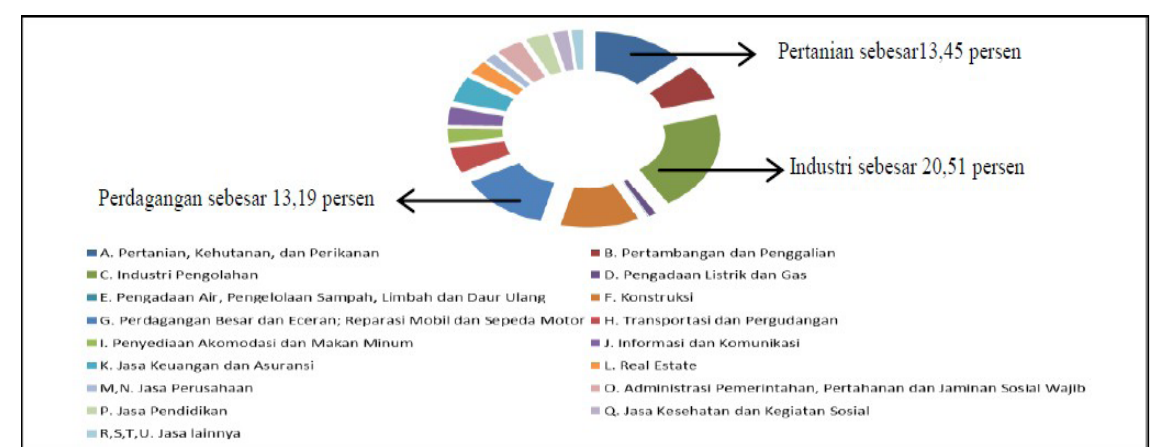
Figure 2(b): Sectoral Contribution by 2016 (in percent) Source: Badan Pusat Statistik,